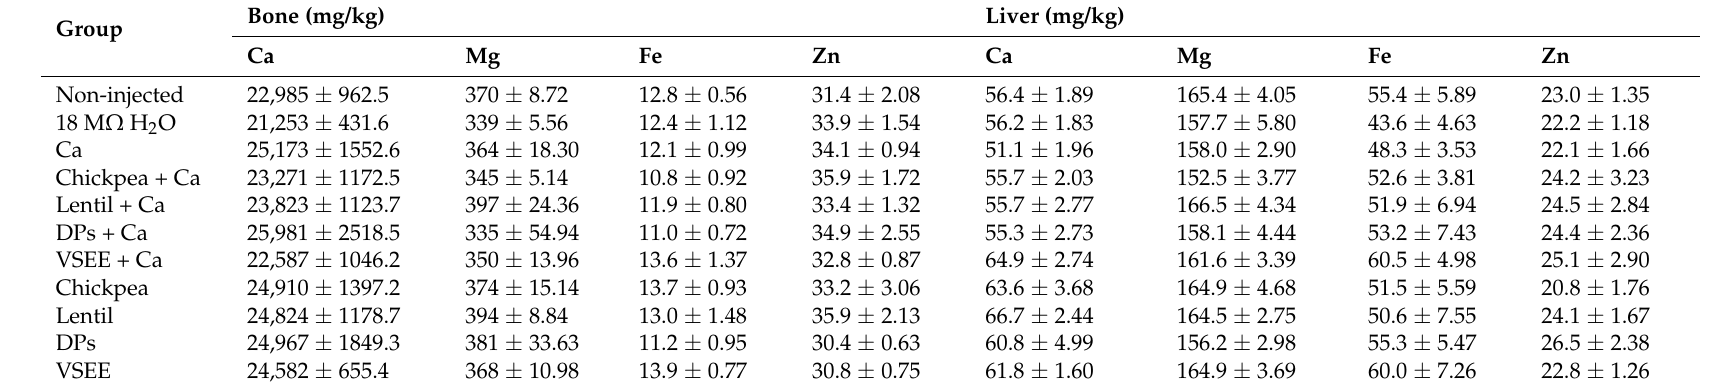
Table 2. Effect of chickpea prebiotics, lentil prebiotics, DPs and VSEE on the Bone and liver mineral